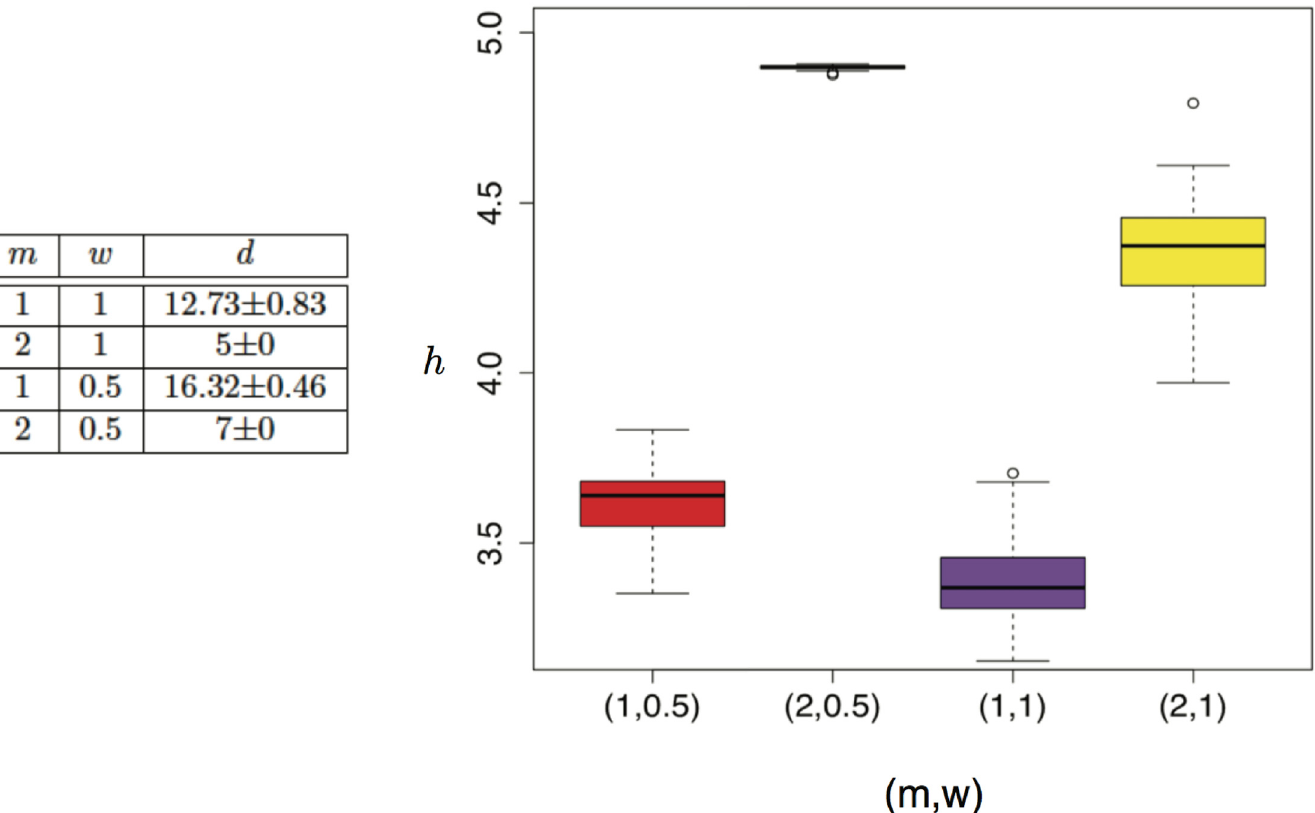
Fig 3. power-hop exponent h for two different types of the BA preferential attachment networks. Increasing the number of edges m that a new node generates leads to a decrease in the (effective) diameter since more edges can create shortcuts in the network with higher probability. Sub-linear attachment also leads to higher (effective) diameter, since the hub nodes do not attract the new edges as strongly as in the linear attachment (see table on the left). Reducing the number of edges while keeping the number of nodes and preferential attachment type constant generates less complex networks (networks with a smaller power-hop exponent). A similar result occurs if we increase the preferential attachment probability while keeping the number of nodes and edges